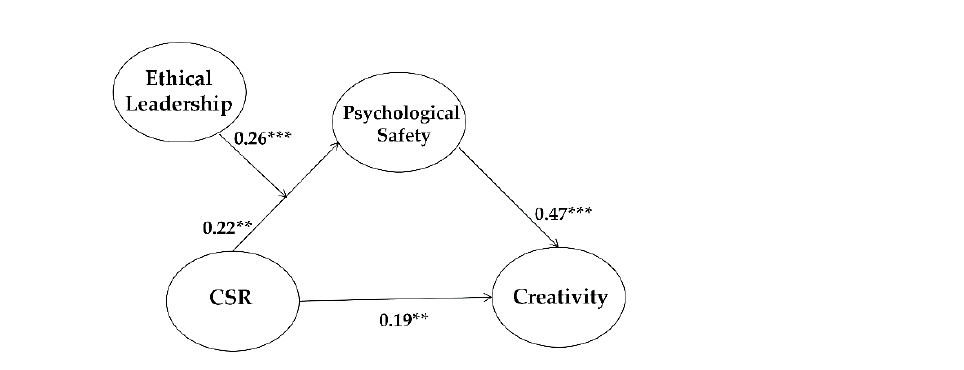
Figure 3. Final structural model. Standardized coefficients are presented. ** p < 0.01, *** p < 0.001. Table 4. Direct, indirect, and total effects of the final research model.